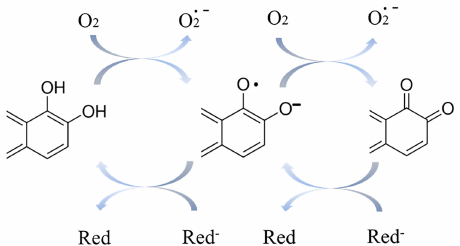
Figure 1. A simplified mechanism of redox cycling of quinone-like substances and formation of superoxide anion radicals. Red shows a general reductant. In the redox cycle, regenerated quinone serves as a chemical intermediate to transfer electrons from reductants to (cid:113) − oxygen to form superoxide (O 2